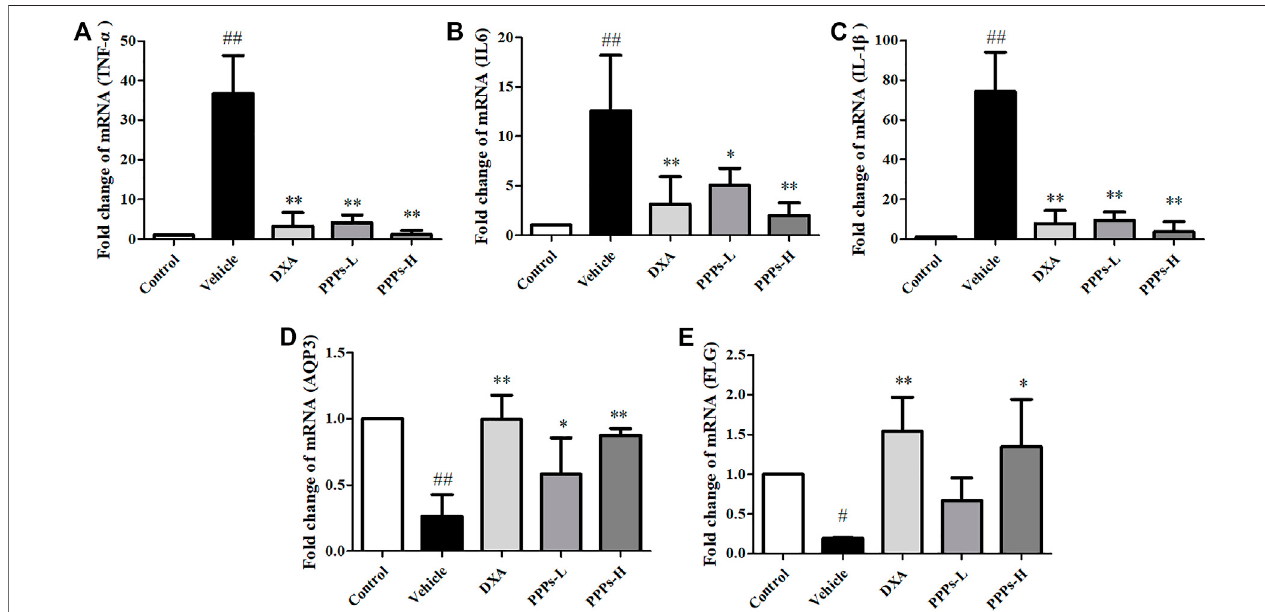
FIGURE5| Effectof Punicagranatum peelpolysaccharides(PPPs)onthemRNAexpressionsofin fl ammatorycytokines,aquaporin-3(AQP3),and fi laggrin(FLG)in imiquimod (IMQ)-elicited psoriasis. Mice were treated with dexamethasone (DXA) and PPPs and topically administered with IMQ. The mRNA expressions of TNF- α (A) ,